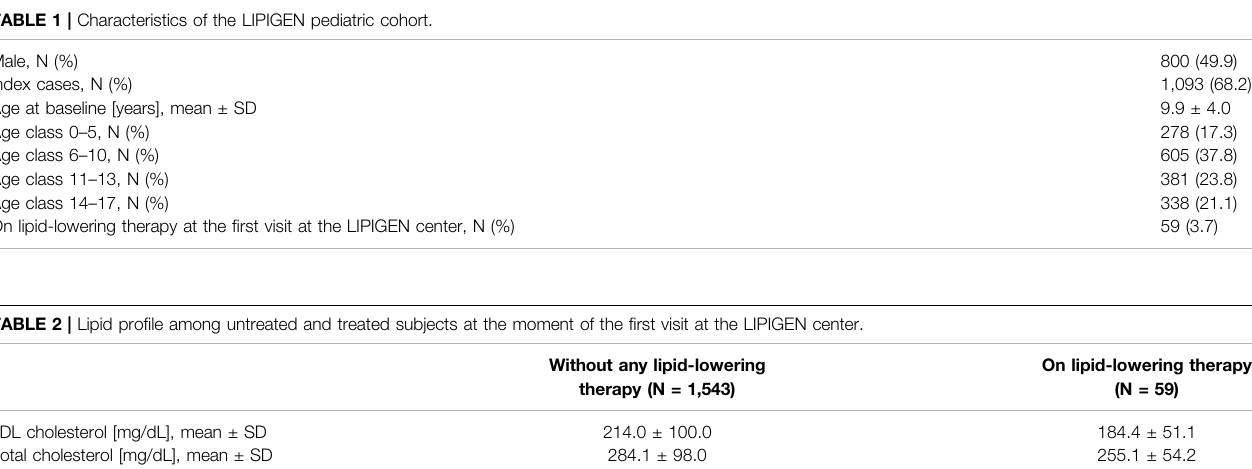
*IQR, interquartile range.